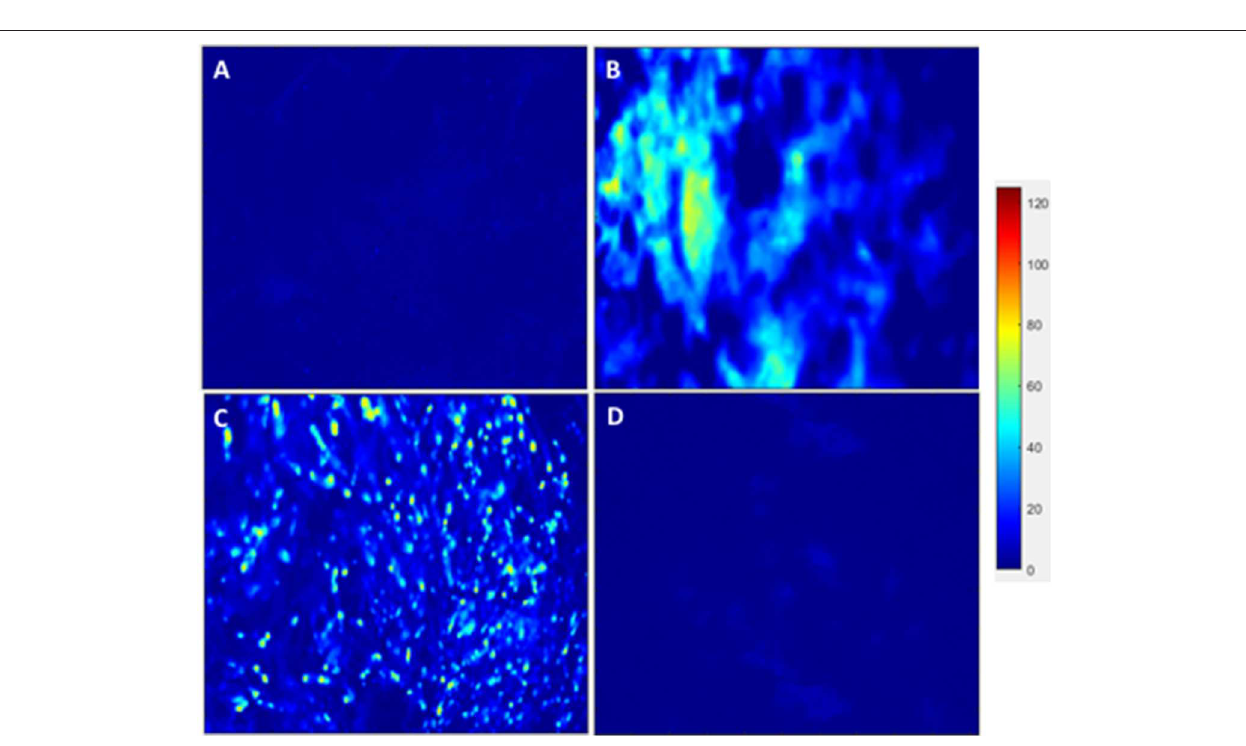
toward the endothelial phenotype (19, 21–23). This supports our finding that the oscillatory flow group had a higher CD31 expression (endothelial phenotype). Studies in valve tissue engineering have suggested that valvular endothelial cells (VECs; CD31 marker) are the critical factor needed when compared to the valvular interstitial cells (VICs; α -SMA